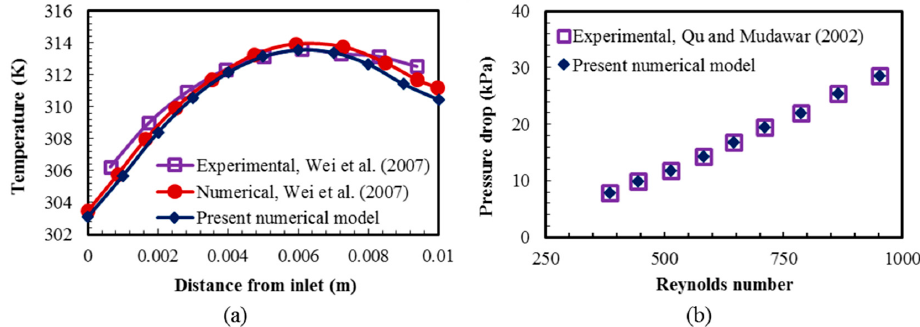
Figure 5. Validations of numerical results compared with: ( a ) experimental and numerical results obtained by Wei et al. [17] in a double-layer counter-flow heat sink for average temperature variation at the bottom surface in the flow direction; and ( b ) experimental results obtained by Qu and Mudawar [46] for the pressure drop in a rectangular microchannel with a heat flux of 200 W/cm 2